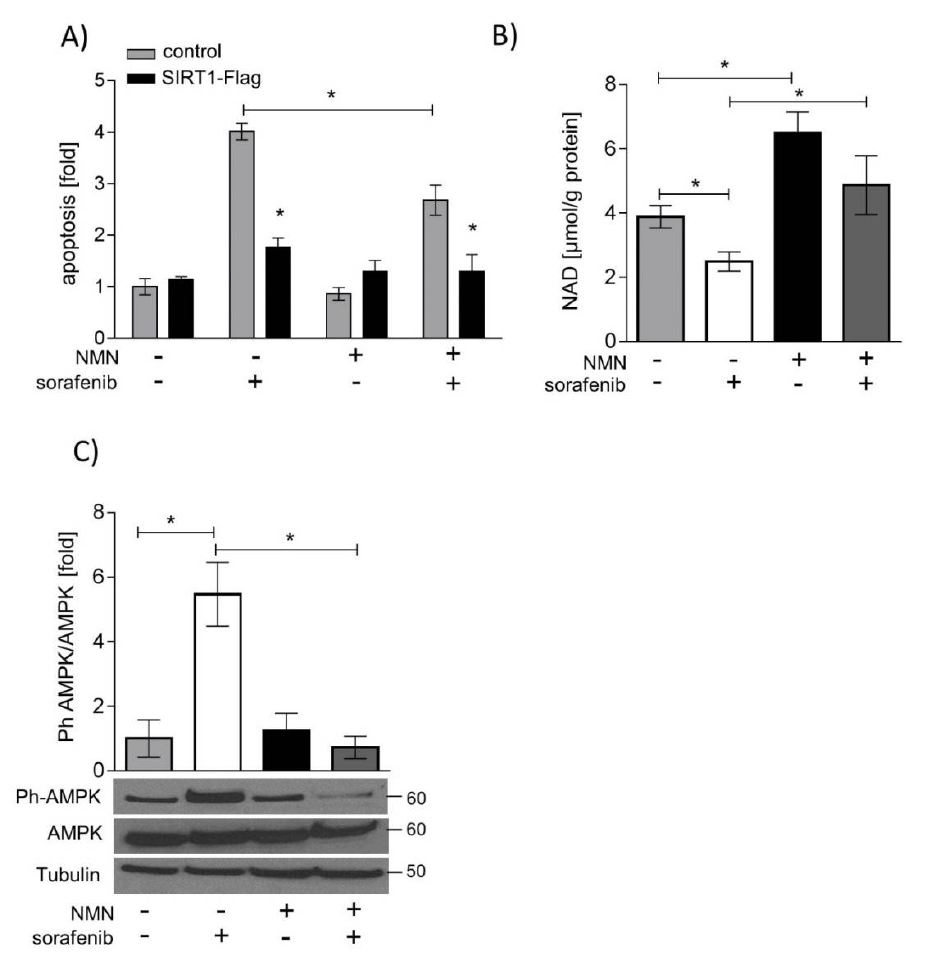
Figure 5. SIRT1 overexpression and nicotinamide mononucleotide (NMN) supplementation suppress apoptosis induction by sorafenib. HUH7 cells were stimulated with sorafenib (5 µ M), NMN (250 µ M), or a combination of sorafenib and NMN. ( A ) SIRT1 was overexpressed in HUH7 cells by electroporation. Apoptosis was determined by FITC Annexin V Apoptosis Detection Kit and flow cytometry. Annexin V-FITC positive cells and Annexin-V-FITC and PI-positive cells were defined as apoptotic cells ( n = 3). ( B ) Intracellular NAD levels were measured by gradient HPLC / UV analysis ( n = 3). ( C ) Phosphorylated AMPK was normalized to total AMPK and loading control (Tubulin). One representative blot out of three experiments is shown. The mean value of solvent control (DMSO) was used to normalize values of the respective datasets. One representative blot out of three experiments is shown. Data are shown as mean ± SEM. * p < 0.05.